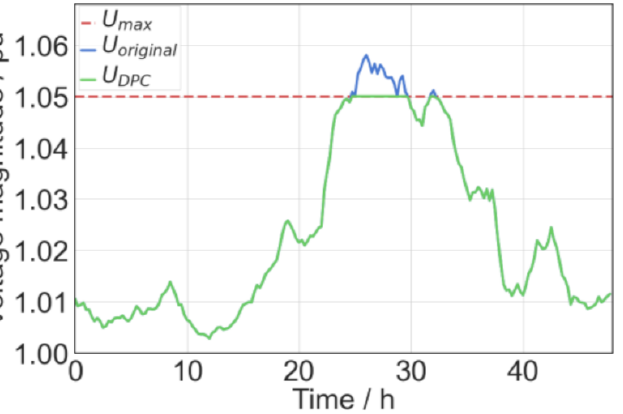
Figure 18. Voltage magnitude on node 5, initially (blue trace) and after application of DPC (green trace).